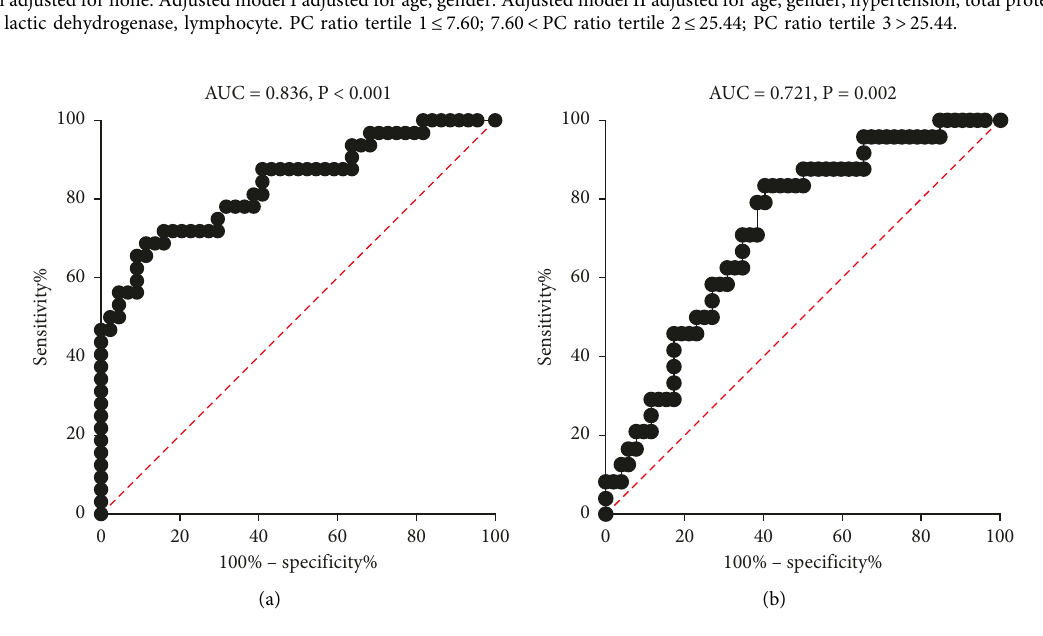
Figure 2: PC ratio ROCs. (a) PC ratio ROC on diagnosing moderate-to-severe pneumonia. (b) PC ratio ROC on diagnosing GI initial GI involvement.